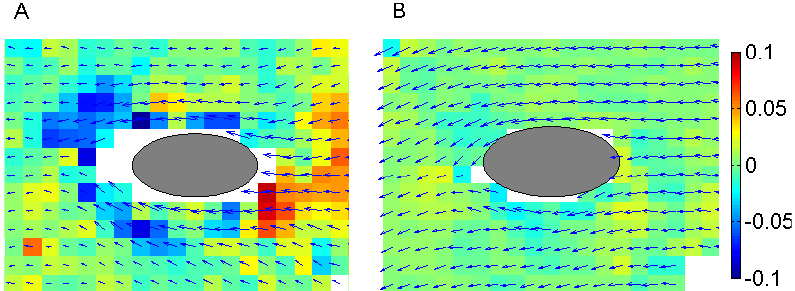
Figure 5. Velocity vectors surrounding a single cell swimming at the WAI. The color indicates the surface divergence of the surface velocity normalized by the swimming velocity of the cell. (A) Without a surfactant (B) With * 0.04 mM/m 3 of surfactant.